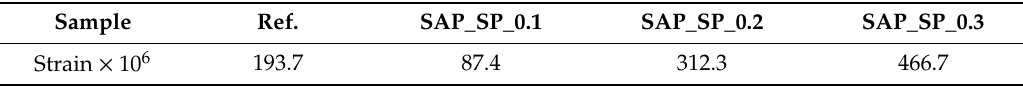
Figure 6. Strain on mortar samples ( a ) Ref. ( b ) SAP_SP_0.1 ( c ) SAP_SP_0.2 ( d ) SAP_SP_0.3 during the four freeze–thaw cycles. Table 4. Average peak points of the strains on three specimens for each series during the freezing phase of the fourth